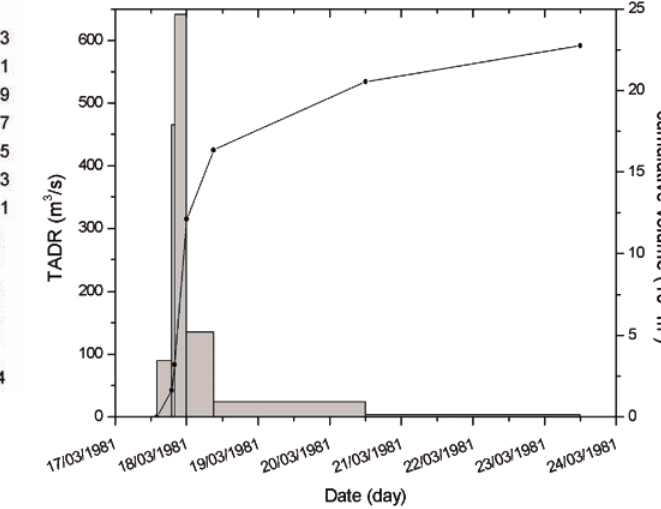
Figure 7. Temporal evolution of the TADR (left axis) and corresponding cumulative volumes (right axis) during the 1981 Etna eruption.